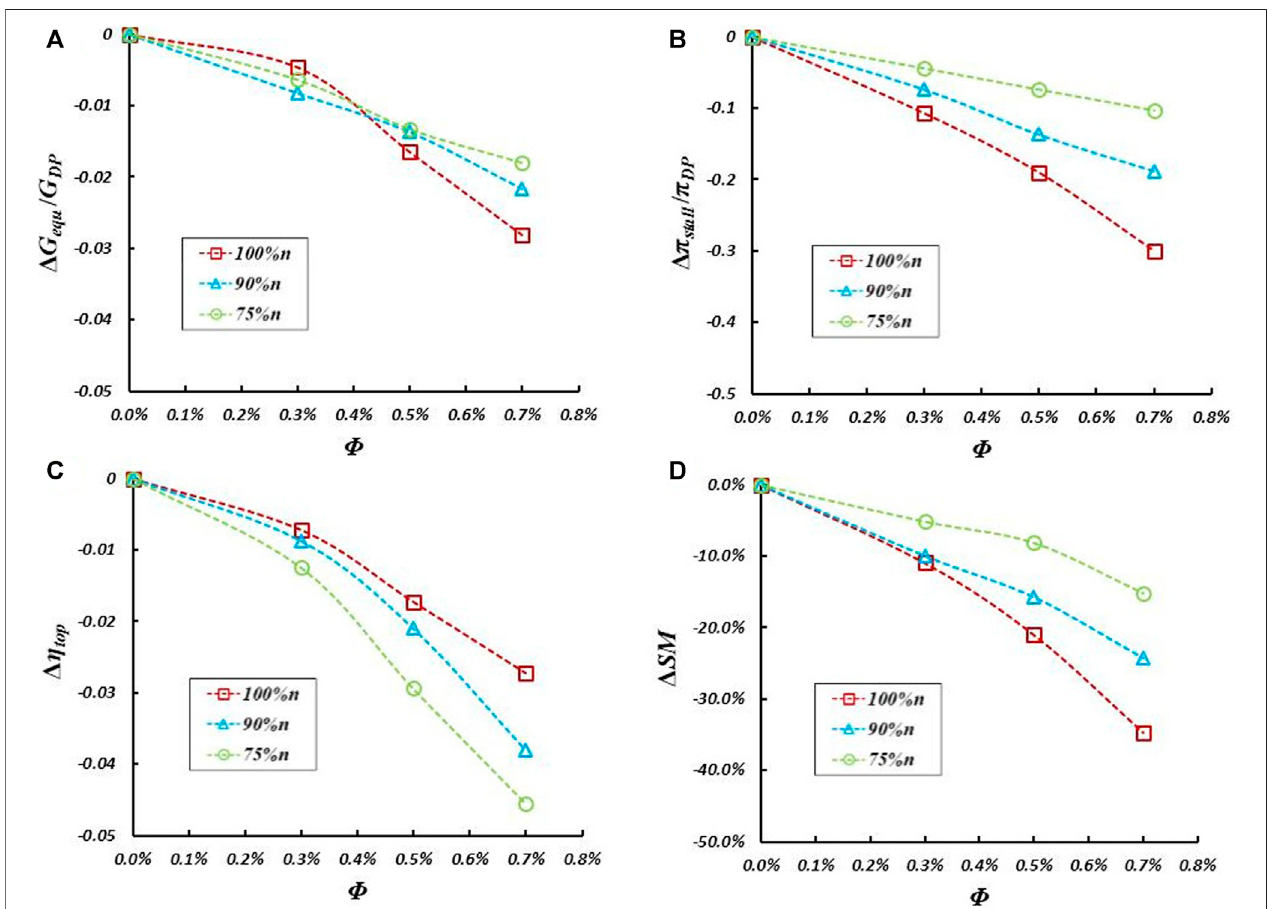
Figure 4 . According to the results, the compressor performance parameters are considered suf fi ciently re fi ned to obtain results which are independent of the grid number after each blade row exceeds 300 thousand grid cells. To minimize the computational time, the case of 300 thousand grid cells for each blade row is determined for considering the nine-stage axial compressor in this study.